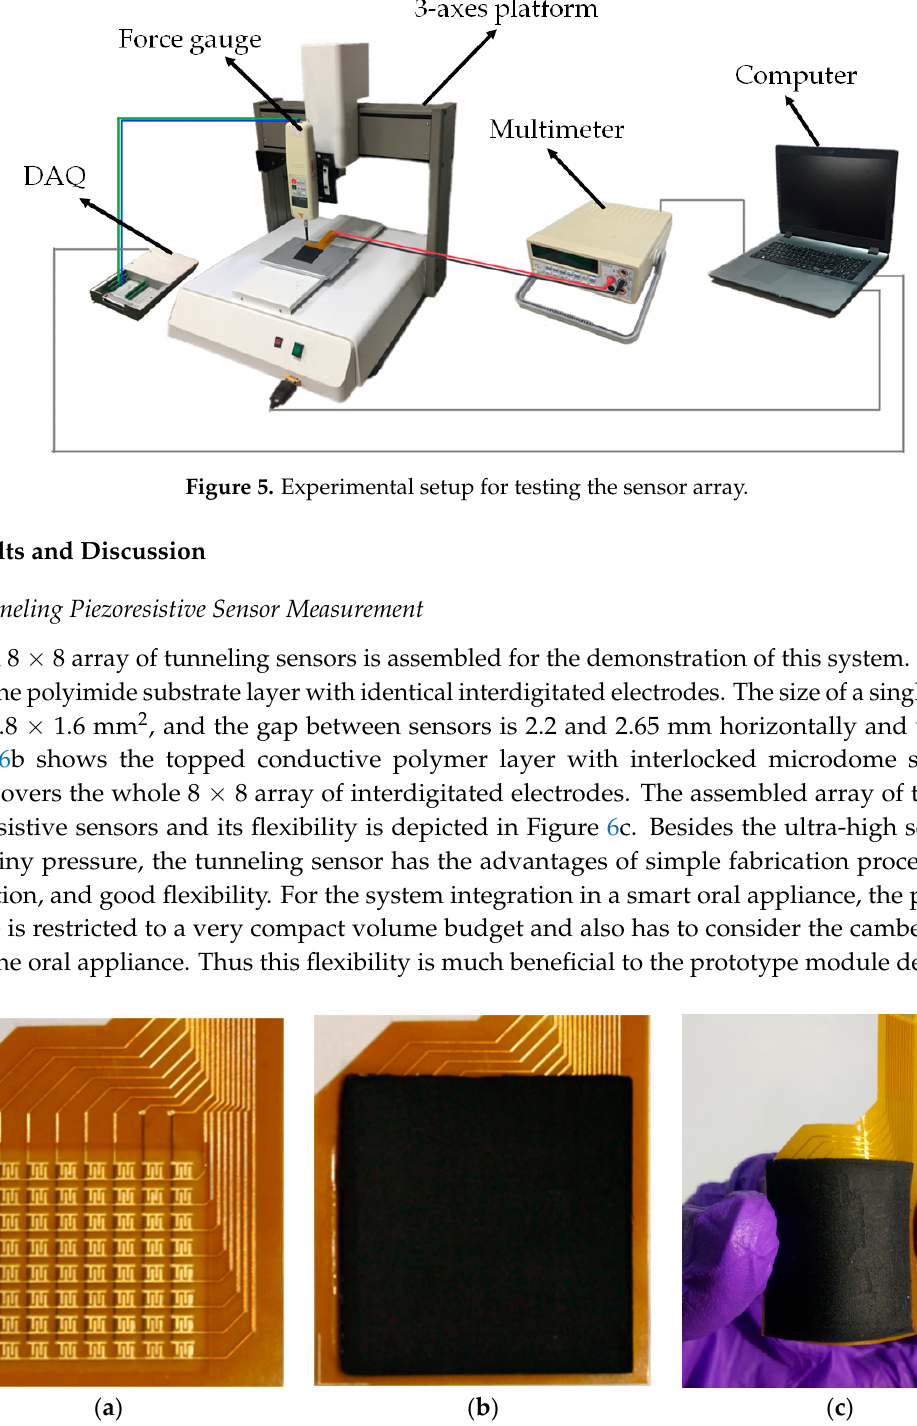
Figure 6. Sensor fabrication results: ( a ) Polyimide substrate layer with interdigitated electrodes; ( b ) Topped conductive polymer layer with interlocked microdome structures; ( c ) Flexibility of the assembled array.